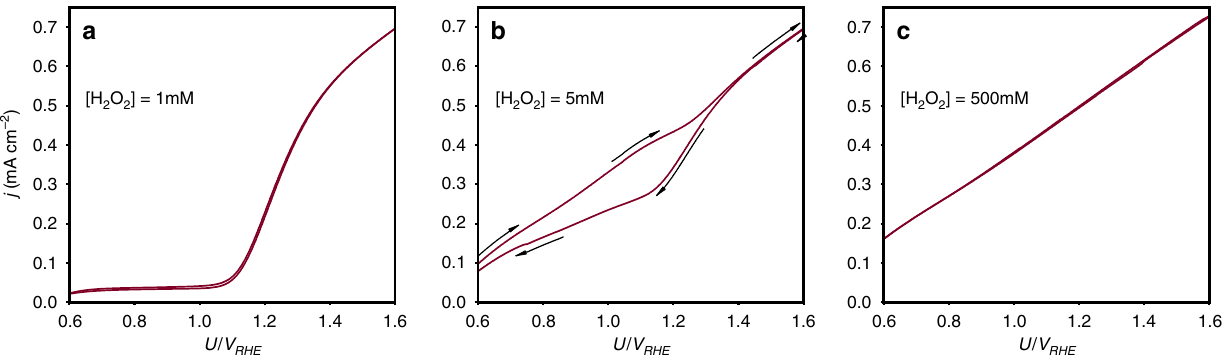
Fig. 6 Experimental realization of hysteresis. Forth and back linear sweep voltammetry scans at different H 2 O 2 concentrations in alkaline solution (1 M NaOH) under white LED illumination of 80 mW cm − 2 : a 1 mM, b 5 mM and c 500 mM. Hysteresis is observed only at [H 2 O 2 ] = 5 mM. The arrows